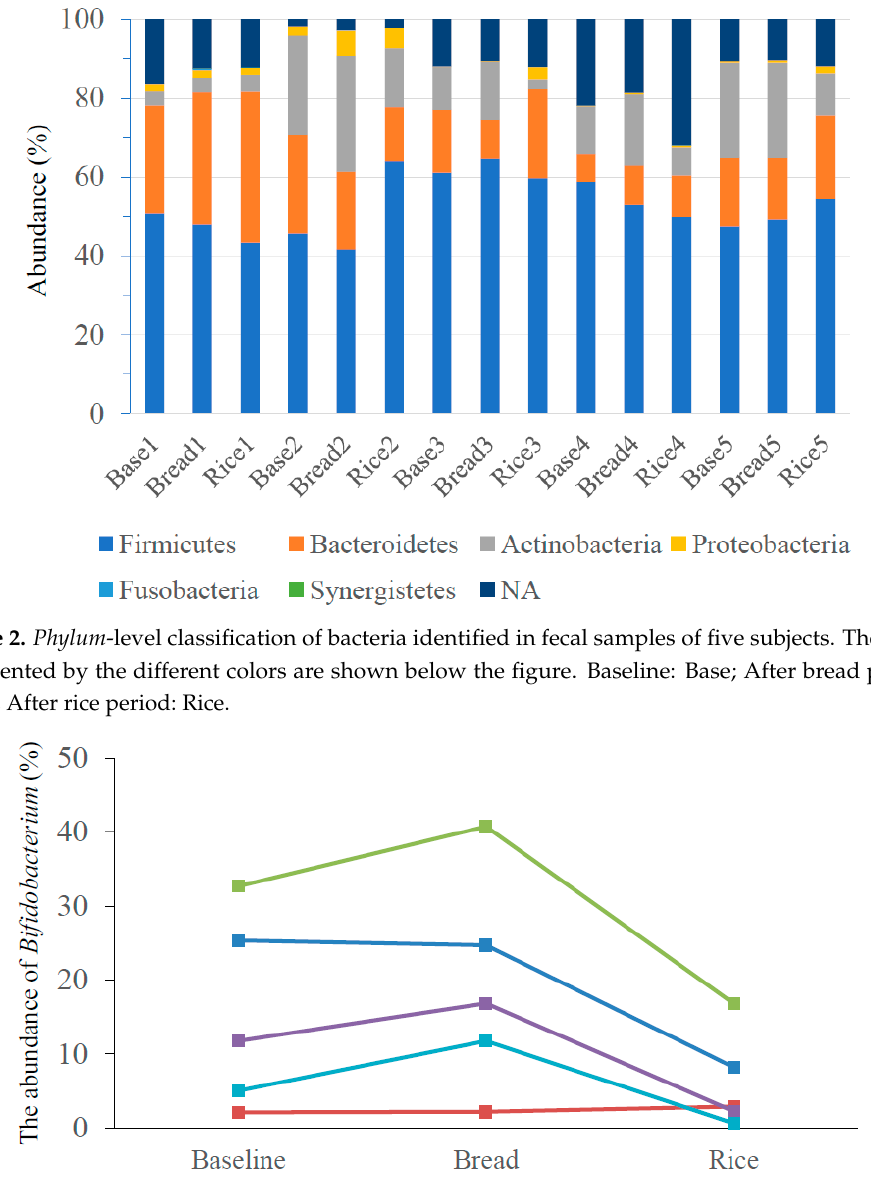
Figure 3. The abundance of Bifidobacterium of five subjects at baseline, after bread period and after rice period. After bread period: Bread; After rice period: Rice. Each color indicates each subject.